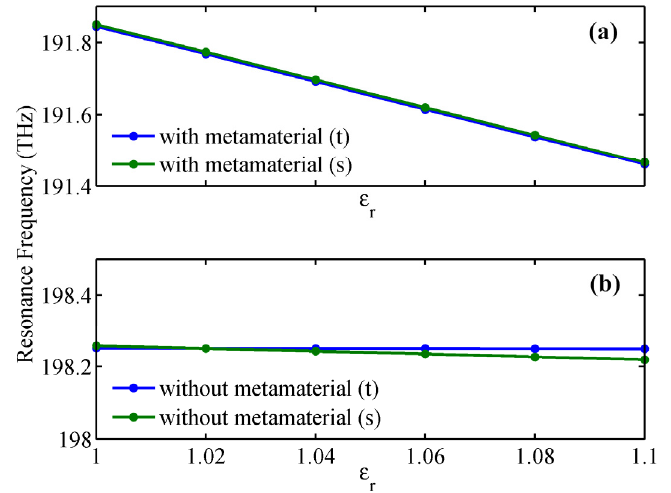
ε and resonant frequency. (a) NPM sensor; (b) Microring Figure 6. Relation between r